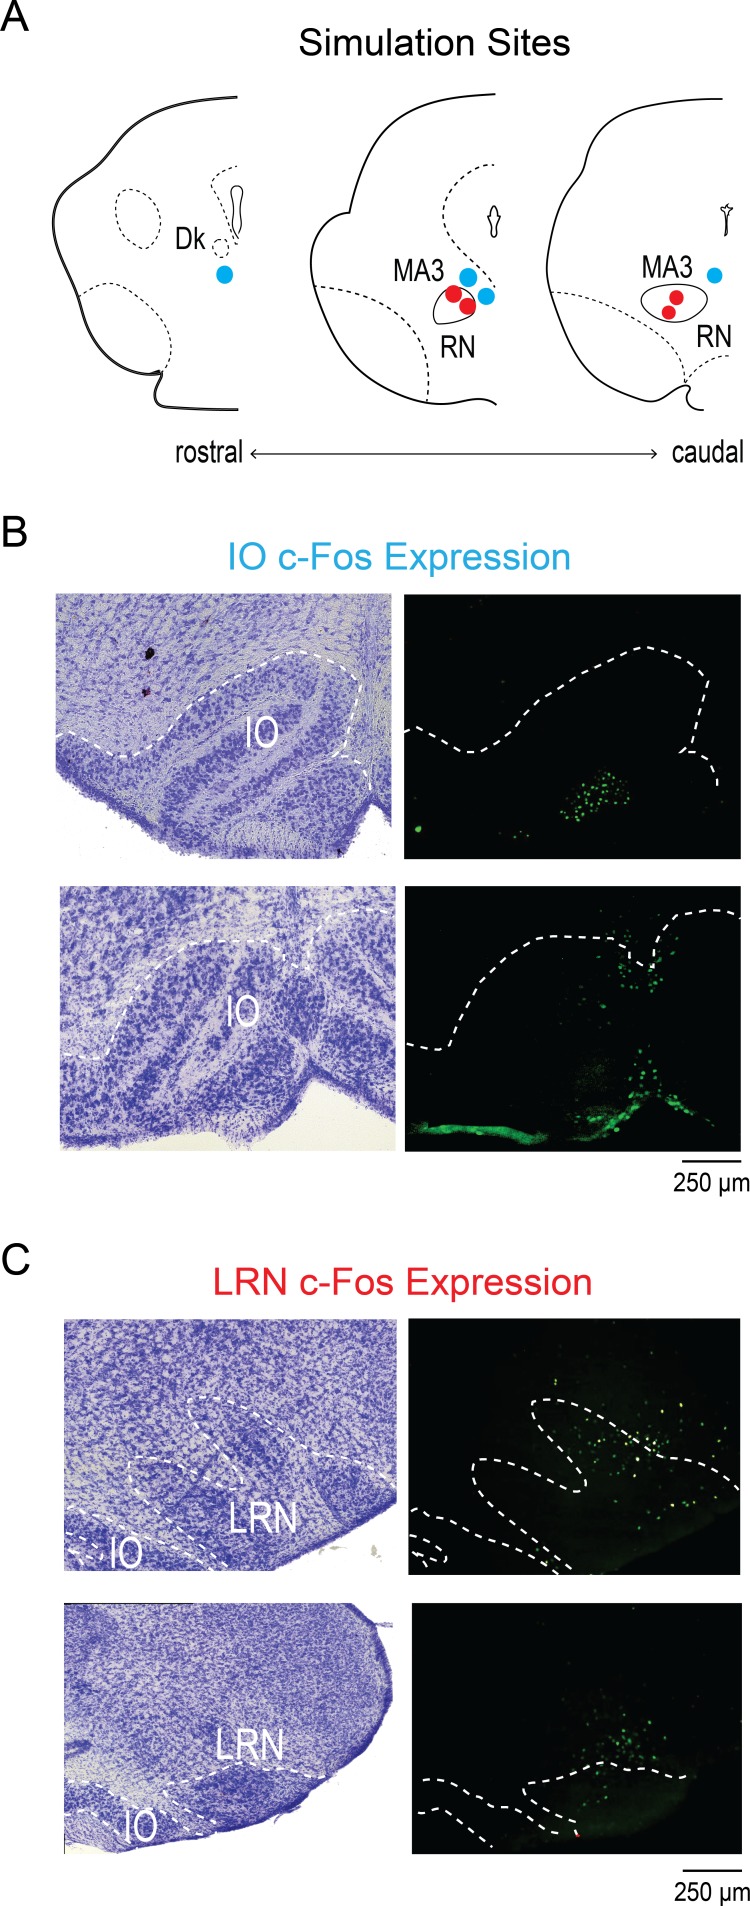
MDJ stimulation increases c-Fos expression in the IO and LRN.(A) Coronal reconstructions of the stimulation sites within the red nucleus (RN; red dots) and in the MDJ region outside the RN (blue dots) in P8 rats. Dk: nucleus Darkschewitsch; MA3: accessory oculomotor nucleus. (B) For two different pups, Nissl-stained sections at the level of the IO (left) and adjacent sections showing c-Fos expression in response to stimulation within the MDJ but outside the RN (blue dots in A). The boundary of the IO is indicated by white dotted lines. (C) For the same pup, Nissl-stained sections at the level of the LRN (left) and adjacent sections showing c-Fos expression in response to RN stimulation (red dots in A). The boundary of the LRN is indicated by white dotted lines.